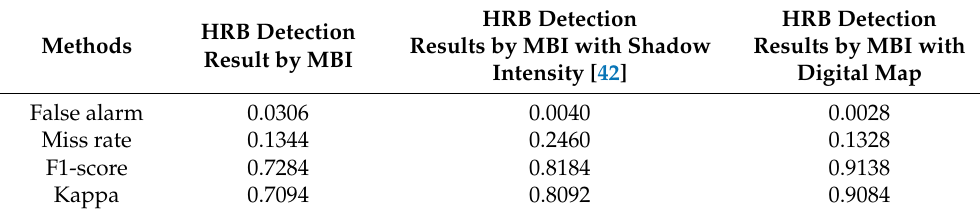
Table 5. Accuracy of HRB detection for Site